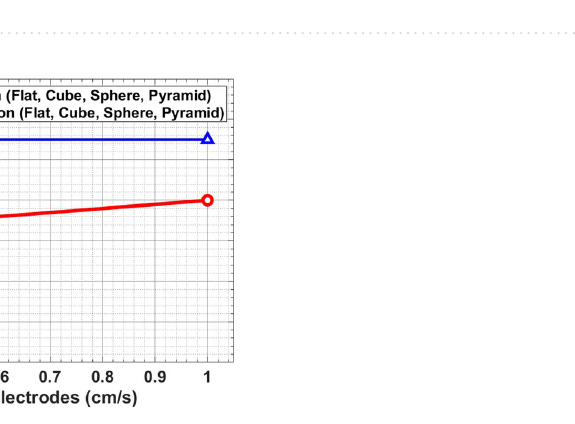
Figure 6. Variations of the firing rate with speed for the resting and firing states in response to the TENG for different electrode